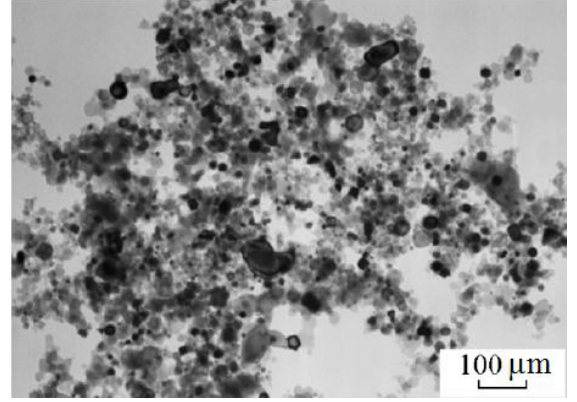
Figure 36. TEM image of the starting TiN powder.